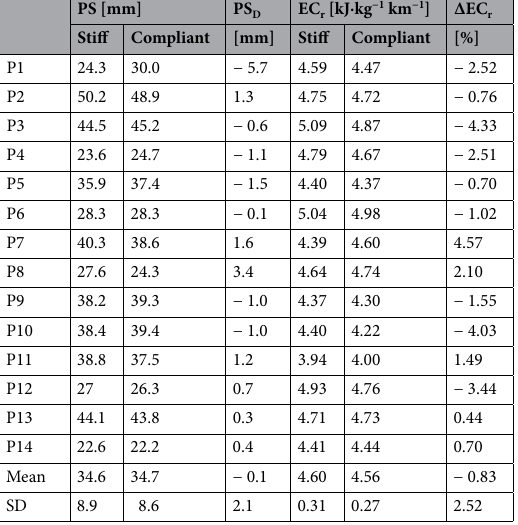
Table 1. Participant values, group mean and standard deviations for pseudo stretch (PS) in each condition, difference in pseudo-stretch (PS